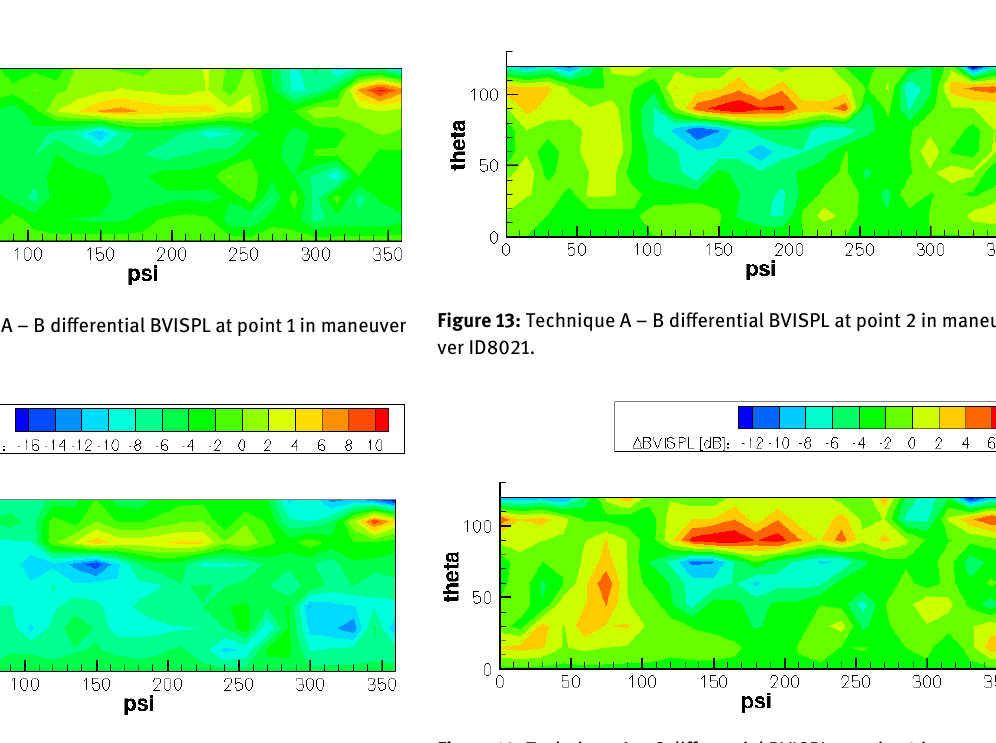
Figure 12: Technique A – C differential BVISPL at point 1 in maneuver ID8021.